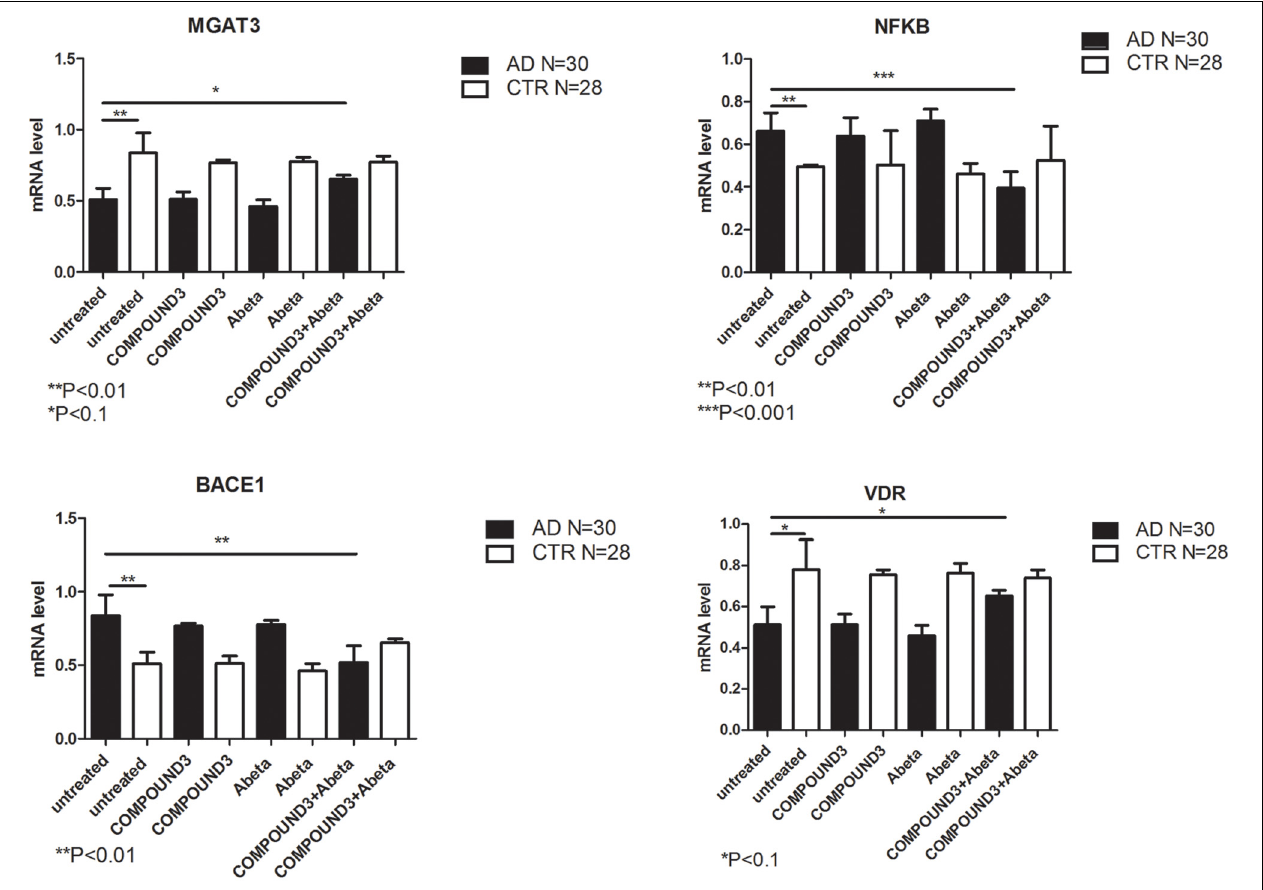
FIGURE 10 | MGAT3 , NF- κ B , BACE1 , and VDR gene expression in PBMCs from AD patients and control subject treated with A β (48 h) and untreated, COMPOUND 3 (24 h) or COMPOUND 3 (24 h) + A β (24